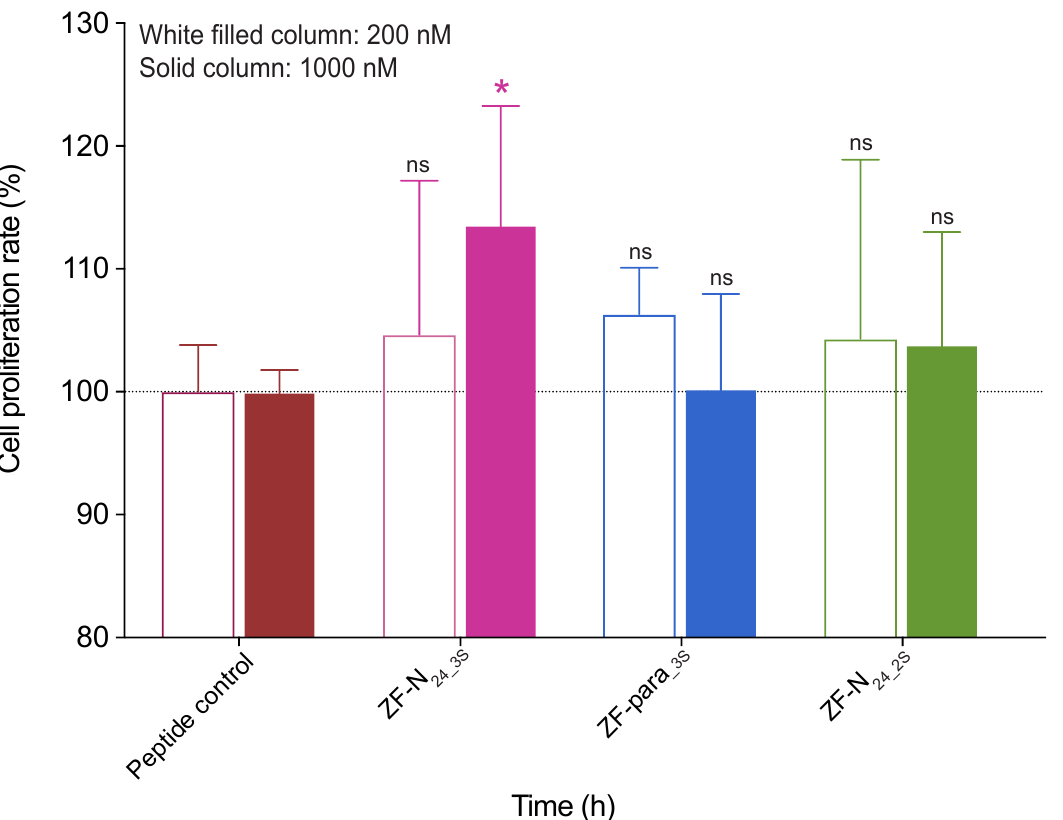
Figure 6. Cell proliferation analysis of granulin peptides using xCELLigence technology. Fibroblast cells were treated with peptides at concentrations of 200 nM and 1 µ M. Data represent mean ± SD of three independent experiments. Data were analysed by one-way ANOVA against peptide control: ns—not significant; ∗ — p < 0.05. Cell index was measured at day 4 after treatment. White-filled columns and solid columns represent concentrations of 200 nM and 1 µ M,